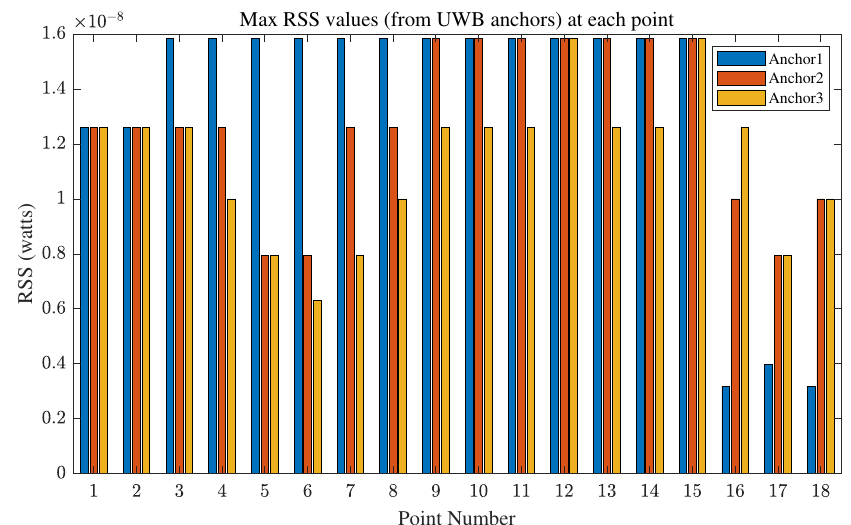
Figure 19. Maximum RSS values in one epoch at each reference point for signals received from three UWB